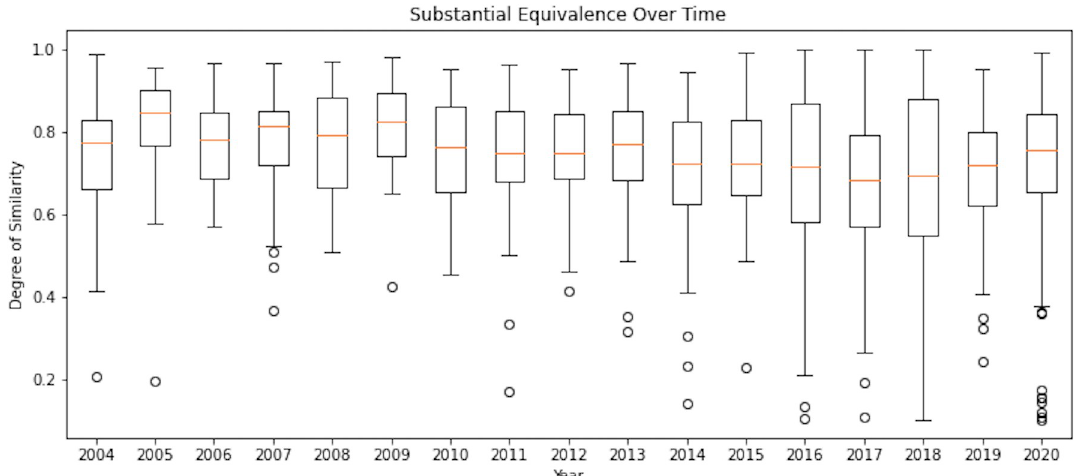
Fig 2. Box and whisker plots for the average equivalence to predicate device across all approved devices each year, from 2003 onwards. The degree of similarity index (y-axis) indicates the level of equivalence between a device and its predicate (1: Identical, 0: Totally dissimilar).